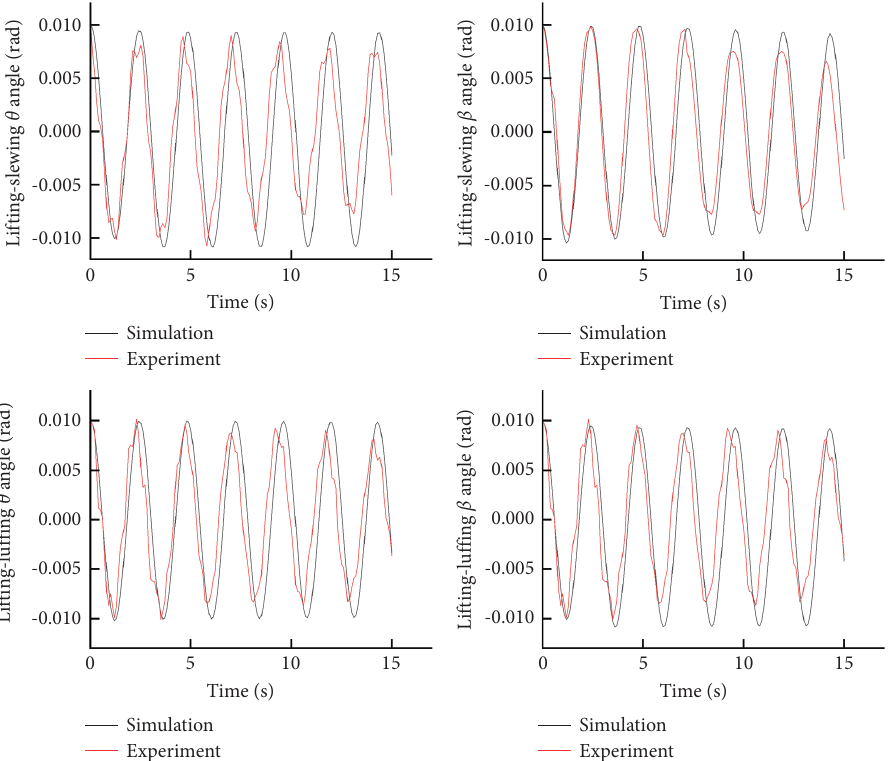
Figure 5: Experimental and simulated swing